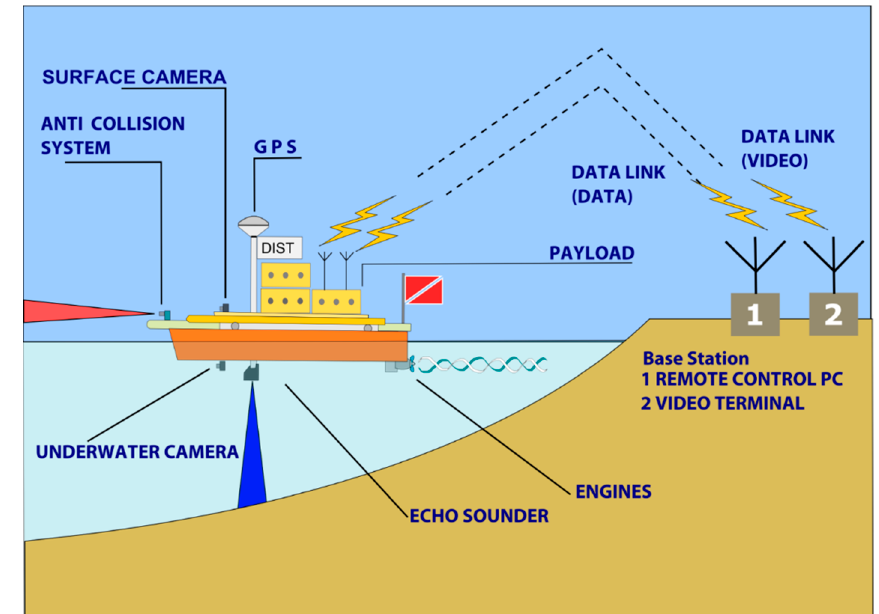
Figure 3. Data acquisition architecture: a base station, with a remote control PC and a video terminal; an on board computerized system that manages the on-board instrumentation; a communication system via data link, to connect the AUVS with the base station.